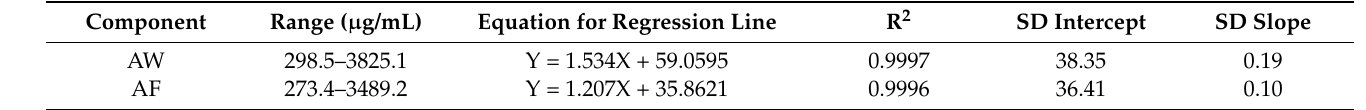
Table 1. Linearity for quercetin